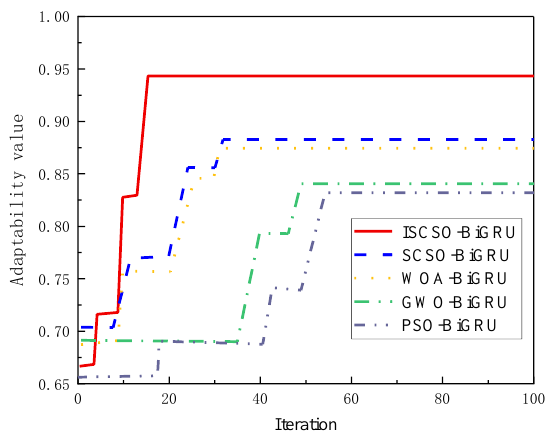
Figure 20. Fault diagnosis results for different models.